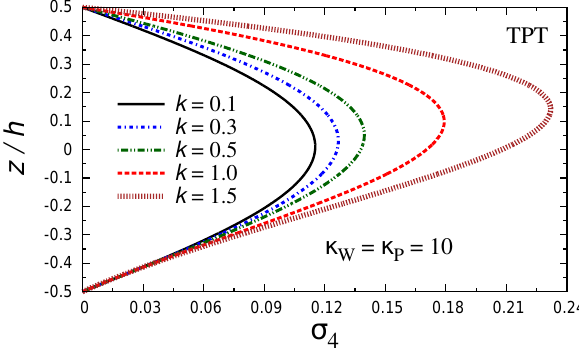
Figure 10: Through-the-thickness distributions of transverse shear stress σ 4 of the EG thick rectangular plate resting on Pasternak parameters ( a = 4 h , b = 3 a ) .